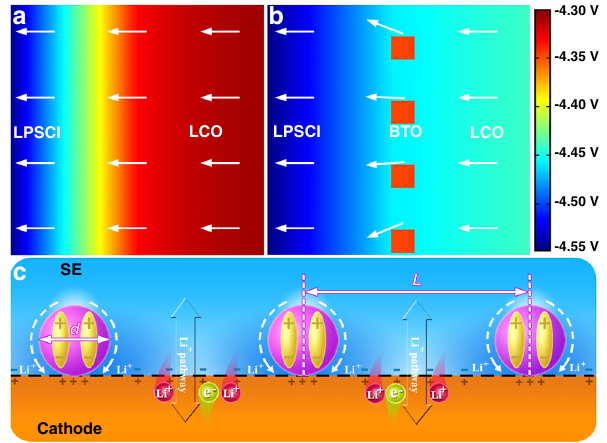
Fig. 6 FEM simulations of the effects of BTO nanocrystals. a , b Simulation results of the internal electrical fi eld for the LCO/LPSCl and BTO – LCO/ LPSCl interfaces. The arrows represent the direction of the internal electrical fi eld. c Schematic illustration of broader interface engineering for suppressing the SCL. The L in c is de fi ned as the distance between neighboring BTO